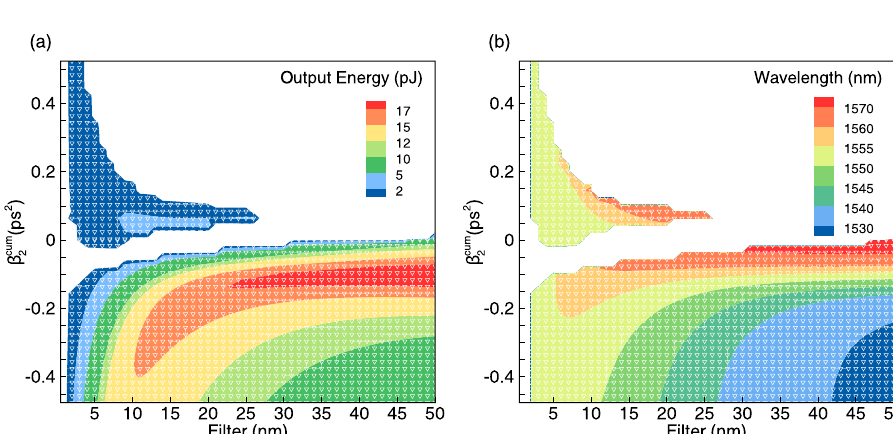
Figure 5. Output pulse energy ( a ) and central wavelength ( b ) as functions of the filter bandwidth and cumulative cavity